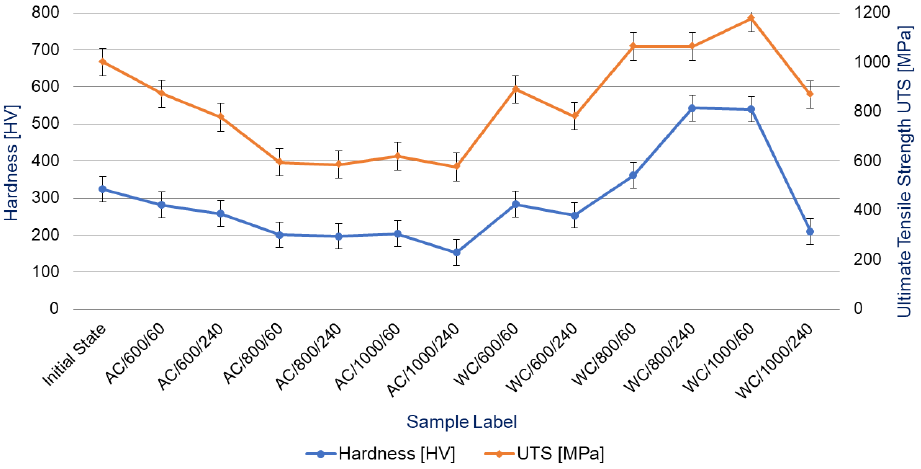
Figure 2. Diagram of correlations between hardness HV and residual tensile strength of the bolt steel after secondary heat treatment depending on parameters of this treatment.